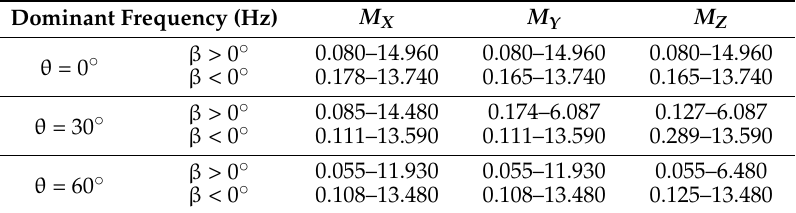
Table 3. Range of the dominant frequency of the total aerodynamic moment of the wind rotor.